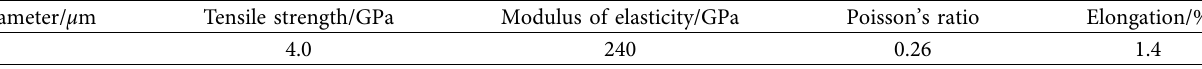
Table 1: Mechanical property parameters of carbon fiber.